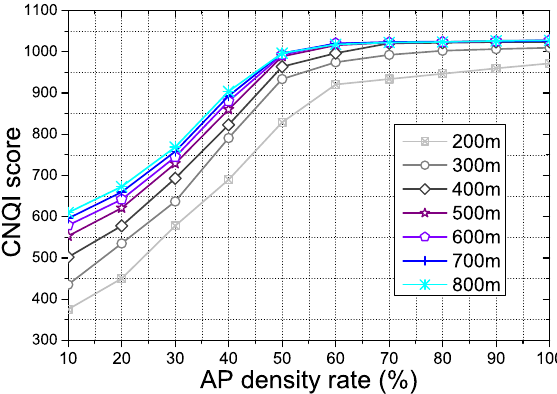
Figure 10. CNQI score for the AP density and communication range.